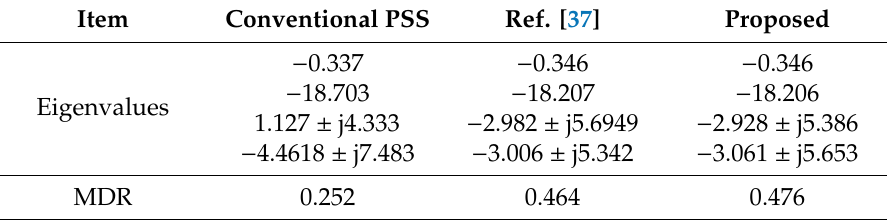
Table 7. Eigenvalues and MDR comparison for the operating situation # 1 (first network).